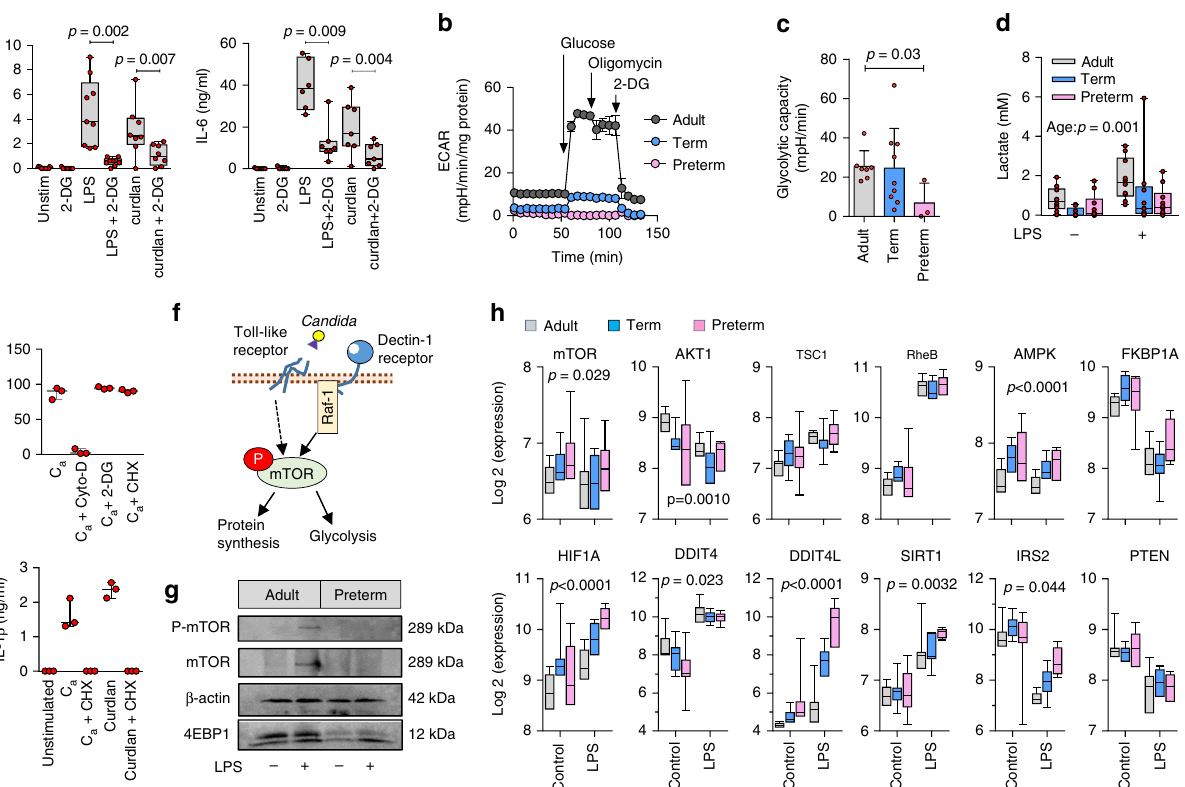
Fig. 7 Impaired glycolysis and mTOR activity in preterm neonatal monocytes. a Effect of blocking glycolysis on cytokine responses to LPS stimulation (24 h) in mononuclear cells (2-sided paired t -tests; boxes and whiskers; 4 to 9 samples per condition; 2-DG = 2-deoxy-d-glucose); b Extracellular acidi fi cation rates (ECAR, normalized to total protein content), under baseline glucose-free conditions, after addition of glucose, oligomycin, and 2-DG (representative experiment from a 29 week gestation preterm sample); c Glycolytic capacity (cumulative data pooled from 4 independent experiments; 3 – 9 subjects per age group; mean ± SD; p value by Mann – Whitney U test); d Lactate production in mononuclear cells after LPS stimulation (24 h); p value = effect of age by 2-way ANOVA. Data from 9 to 10 subjects per age group; boxes and whiskers; e Effect of blocking glycolysis or translation (using cycloheximide, CHX) on the phagocytosis of C. albicans (C a ); boxes and whiskers; 3 subjects; Cyto-D = cytochalasin-D; f Depiction of signaling events between Toll-like receptor and Raf-1-mediated dectin-1 activation, mTOR phosphorylation, and increased glycolysis and protein synthesis; g Western blot image (cropped) of mTOR/ 4EBP1 expression and mTOR phosphorylation (monocytes; preterm sample from 29 weeks gestation; cropped images from same blot probed for mTOR, β - actin, and 4EBP1, and stripped/re-probed for phospho-mTOR); h Expression of mTOR-related genes (monocytes; 6 – 12 per age group; boxes and whiskers; 2-way ANOVA across age groups, only signi fi cant p values are